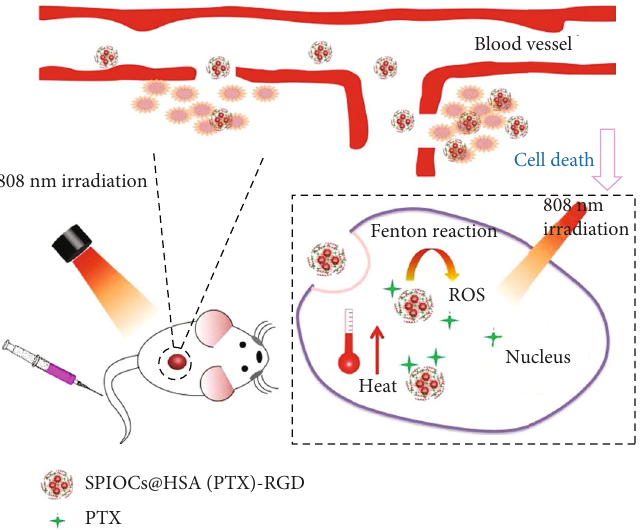
Figure 1: Schematic illustration of SPIOCs@HSA(PTX)-RGD nanoplatforms applied in photothermal mediated chemo/chemodynamic